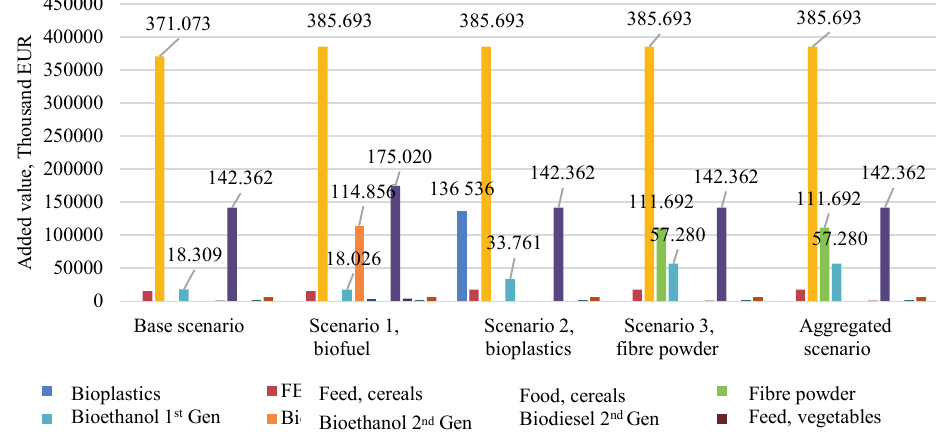
Fig. 8. Scenario analysis for new technologies in agriculture sector in Latvia, year